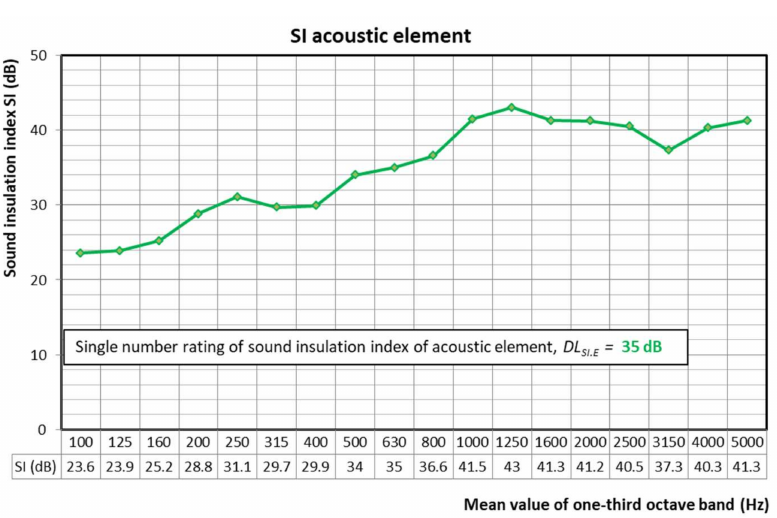
Figure 14. Diagram from the measurement of the airborne sound insulation index of an acoustic element: a polycarbonate